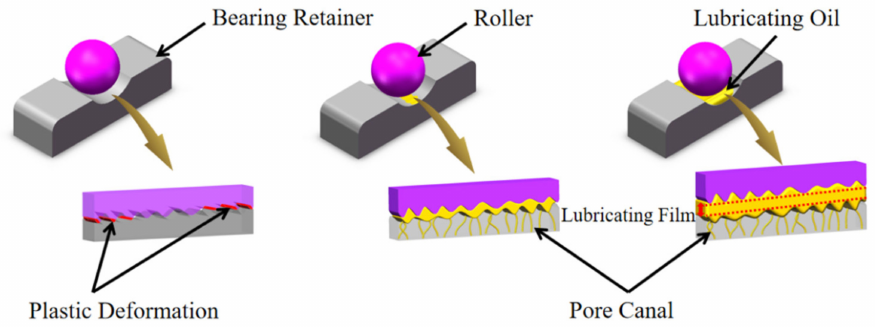
Figure 6. Sliding friction state under different lubrication conditions.